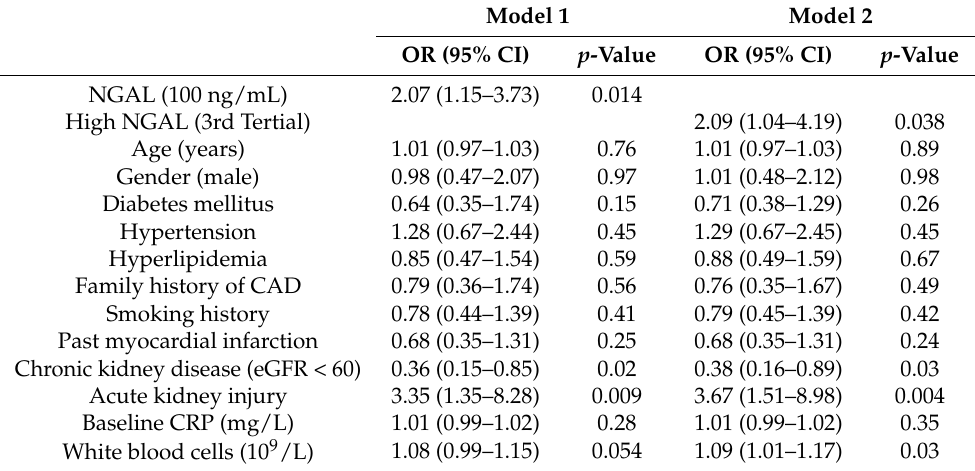
Table 4. Multivariate binary logistic regression analysis for prediction of MACE + .